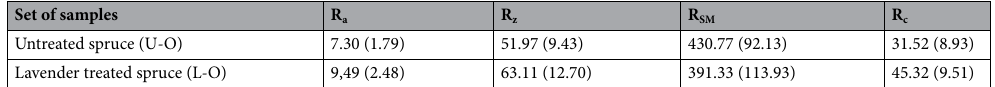
Table 4. Measured roughness of spruce wood without and with lavender treatment. Mean values are from 24 measurements; Numbers in parentheses are SD.